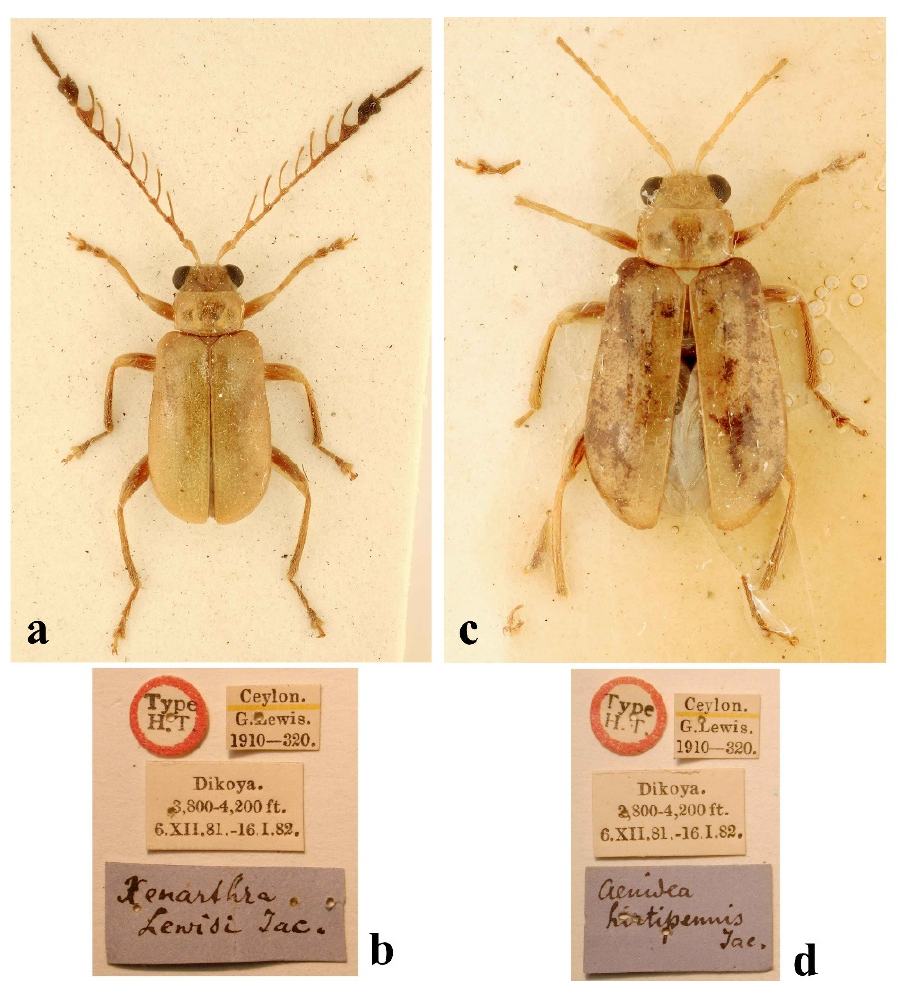
Figure 4. Taumacera lewisi (Jacoby, 1887): ( a ) syntype, male; ( b ) labels; ( c ) holotype of Aenidea hirtipennis Jacoby, 1887, female; ( d ) labels. (Not to scale). Aenidea hirtipennis : Holotype: ♀ (BMNH, Figure 4c,d), “Type/H. T. [white round label red frame, p]//Ceylon./G. Lewis./1910–320. [w, p]//Dikoya./3800–4200 ft./6.XII.81.–16.I.82. [w, p]//Aenidea/hirtipennis/Jac. [b, h]”. Additional material examined. SRI LANKA: Galle District: Kanneliya,